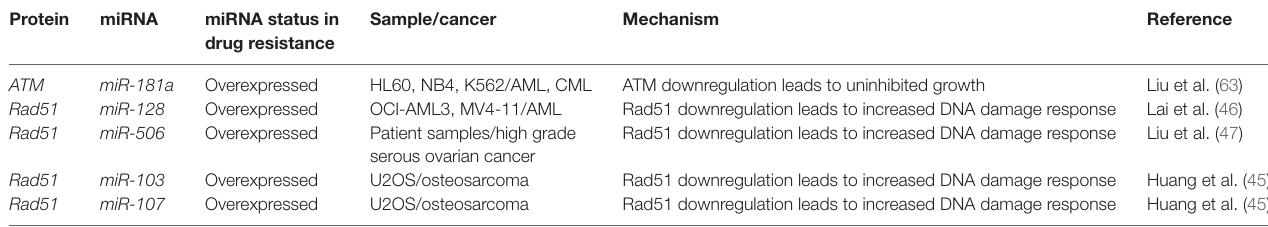
TABLe 1 | miRNAs demonstrated to directly bind to DNA damage regulatory proteins.